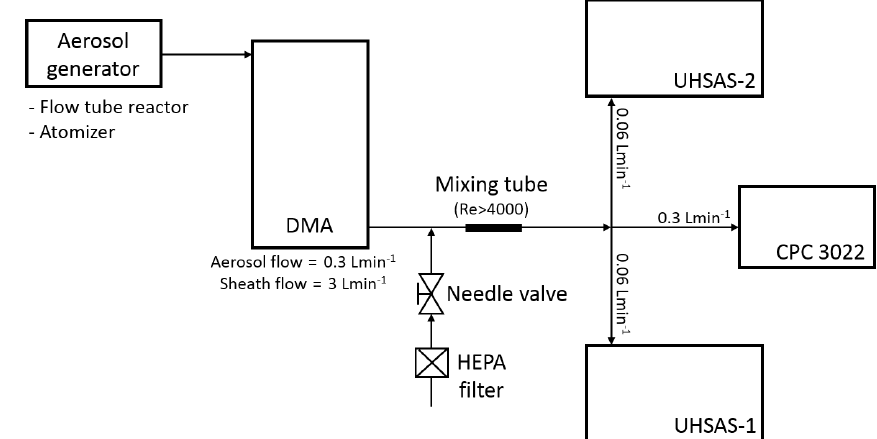
Figure 2. A schematic diagram of the aerosol generation and measurement setup at atmospheric pressure conditions. The calibration aerosol was generated either in a flow tube reactor or the atomizer. Apart from PSL, all atomized particles were sent through a diffusion drier to DMA for size selection, while PSL particles were delivered from the atomizer directly to both UHSAS instruments following dilution with dry